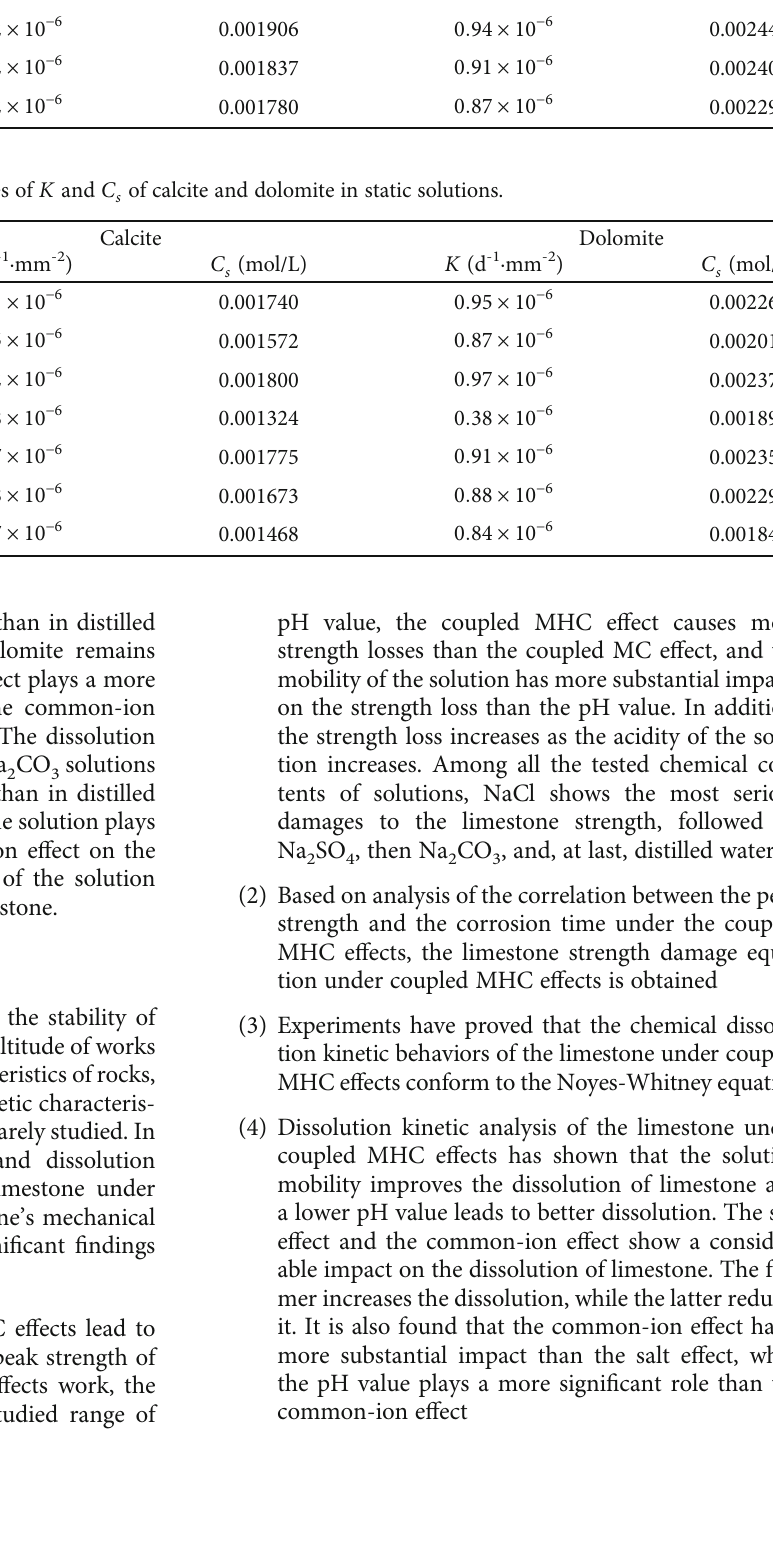
s of calcite and dolomite in